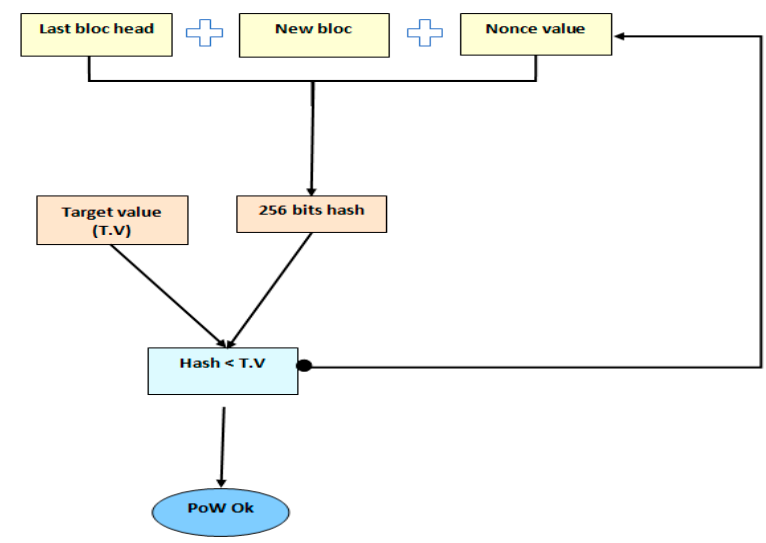
Figure 4. Keccak implementation algorithm.